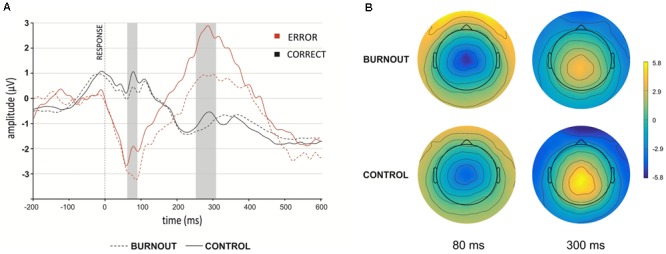
(A) Grand-average error-related potential (ERP) waveform after correct (black line) and incorrect (red line) response at the FCz electrode site for burnout and control group (B). Scalp topography of the error-difference wave (error-correct) 80 and 300 ms after the response for burnout and control group. Gray rectangles denote the time-windows selected for the ERP analyses.